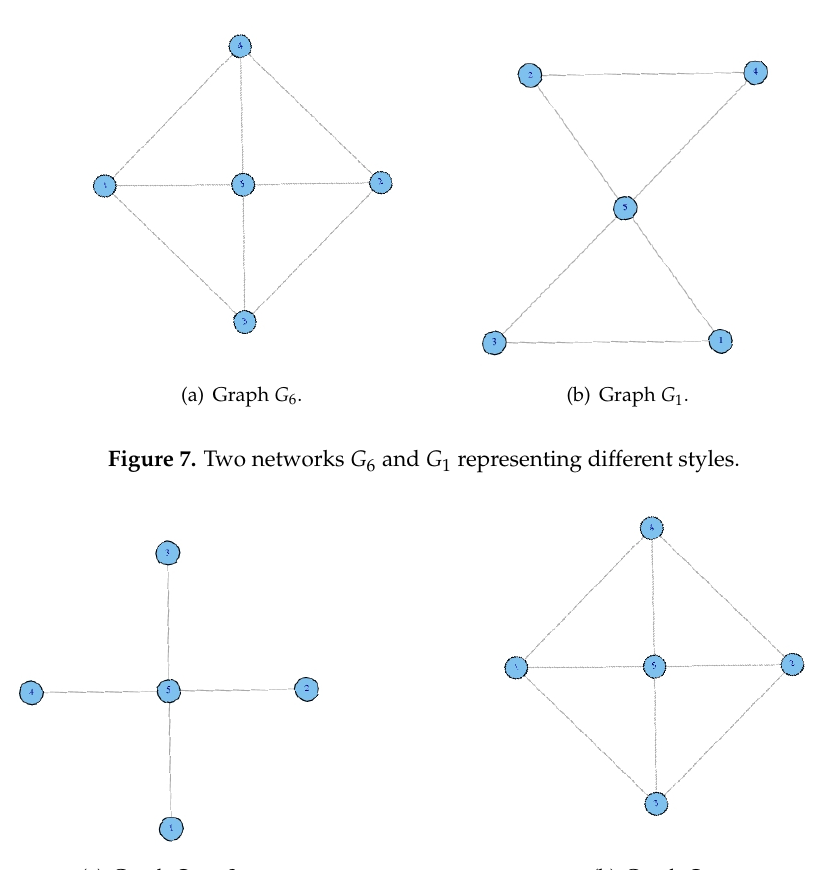
Figure 6. Two networks G 3 = S 5 and G 5 representing different styles.